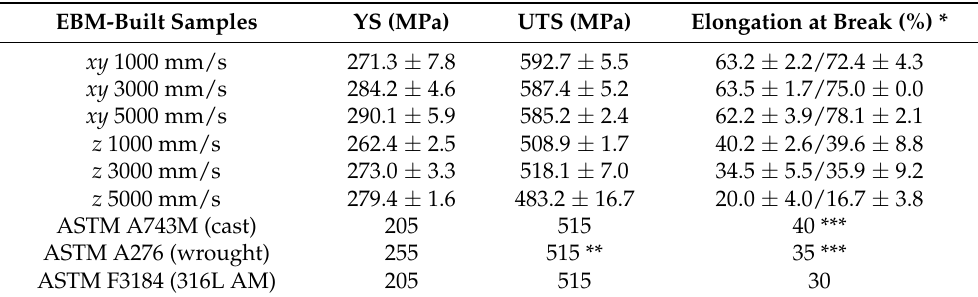
Table 1. Tensile test results of 316LN stainless steel processed via EBM (arithmetic mean ± standard deviation